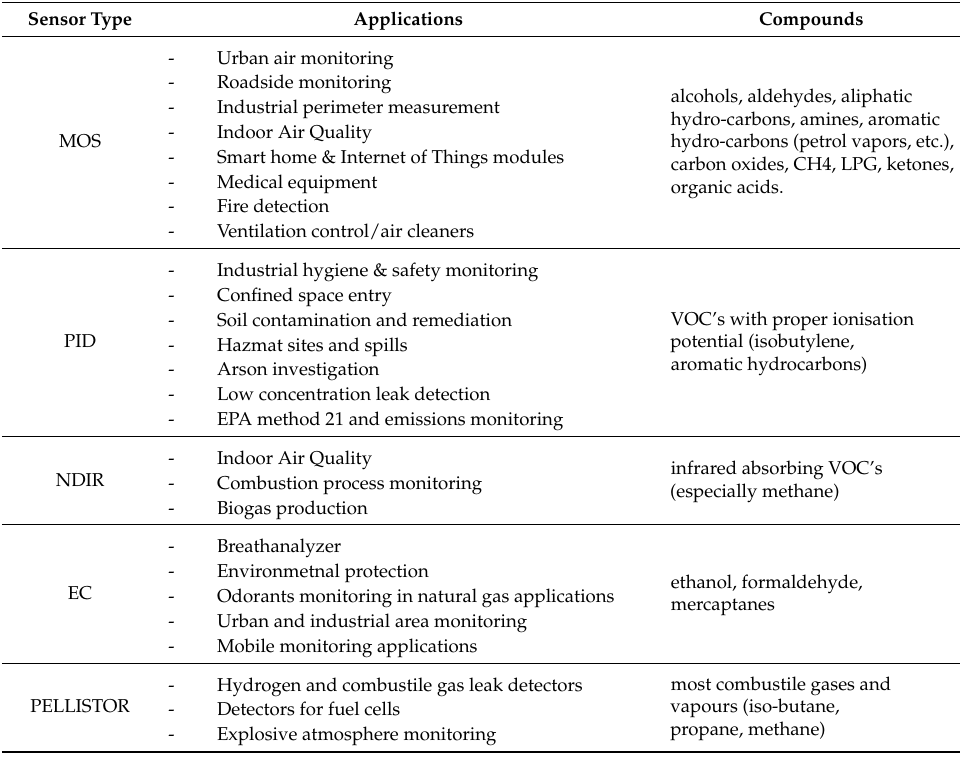
Table 3. Main applications currently commercially available of sensors for determination of VOC.